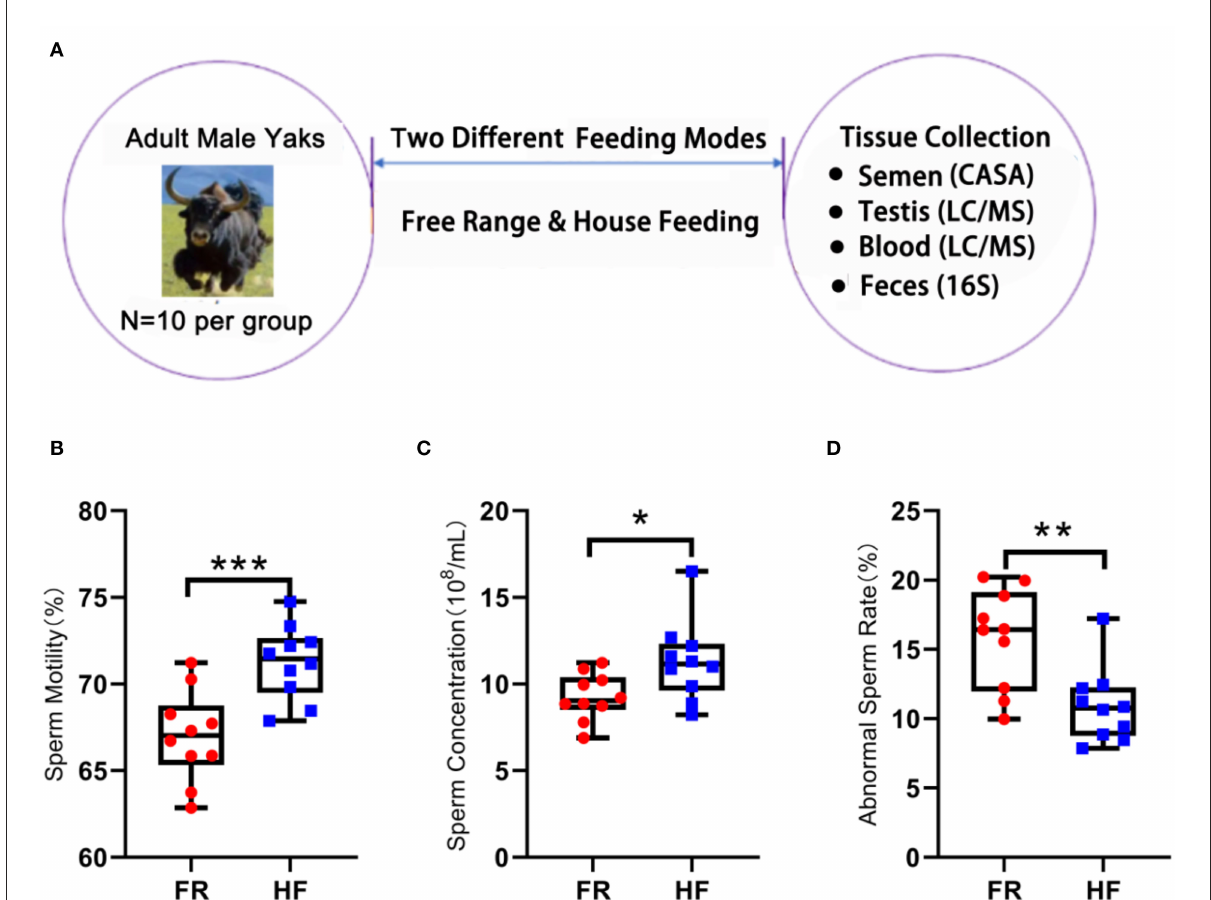
FIGURE1 House feeding modes benefit yak semen quality. (A) Experimental design. (B) Sperm motility is determined by CASA, Y-axis = % of total sperm, X-axis = feeding modes. n = 10. *** P < 0.001. (C) Sperm concentration, Y-axis = sperm concentration (10 8 /ml), X-axis = feeding modes n = 10. * P < 0.05. (D) Abnormal sperm rate. Y-axis = % of abnormal sperm, X-axis = feeding modes. ** P <